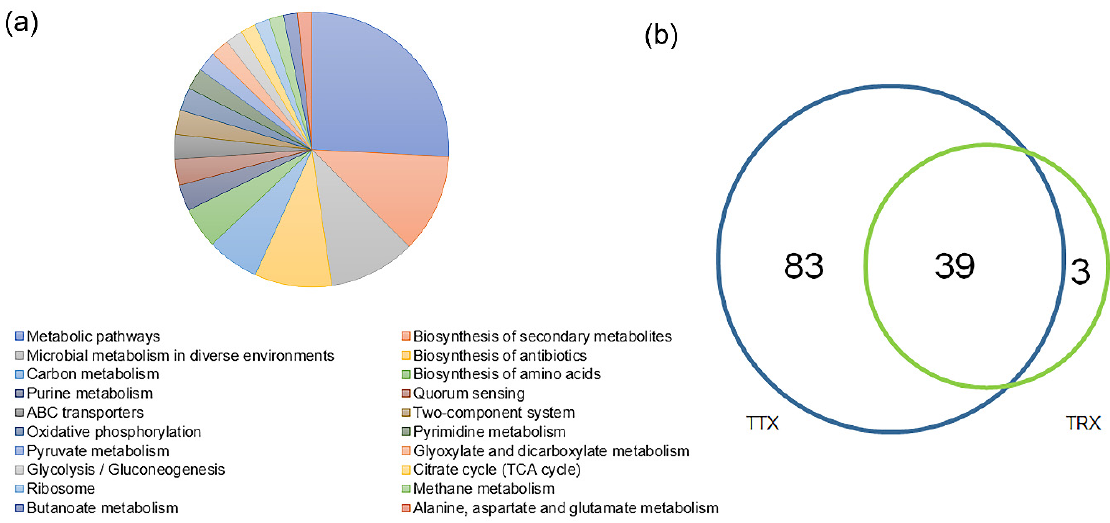
Figure 5. Characterization of the function of the C. henryi rhizosphere micro-biome. ( a ) Functional KEGG level 3 pathways of rhizosphere microbiomes of C. henryi and only the top 20 were shown. ( b ) Venn plot depicting the number of KEGG level 3 pathways based on the relative abundance (>0.01%) in all samples and the pathway enrichment between natural forests and plantation.